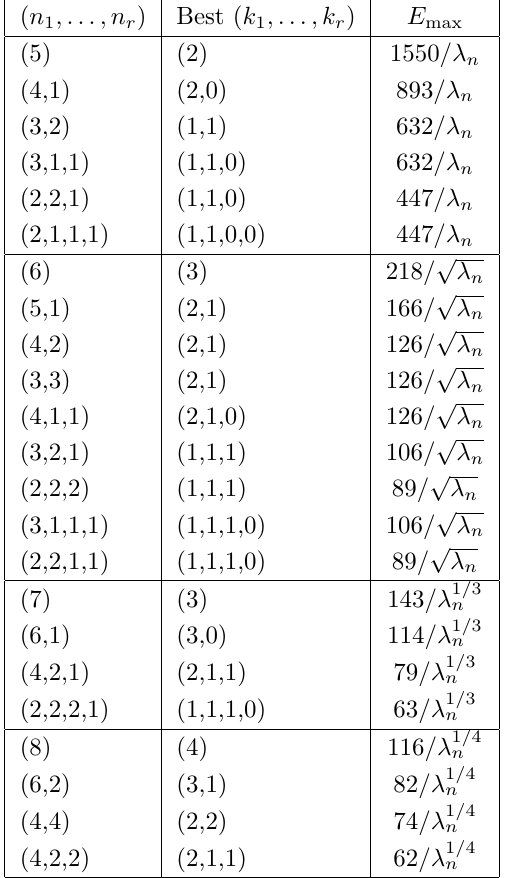
Table 2 . The lowest unitarity violating energy scales for some (cid:12)ve to eight point interactions of the form eq. (A.12), with a representative process that gives the stated bound. where f n ; n ; n g represents the number of goldstones f G 1 2 3